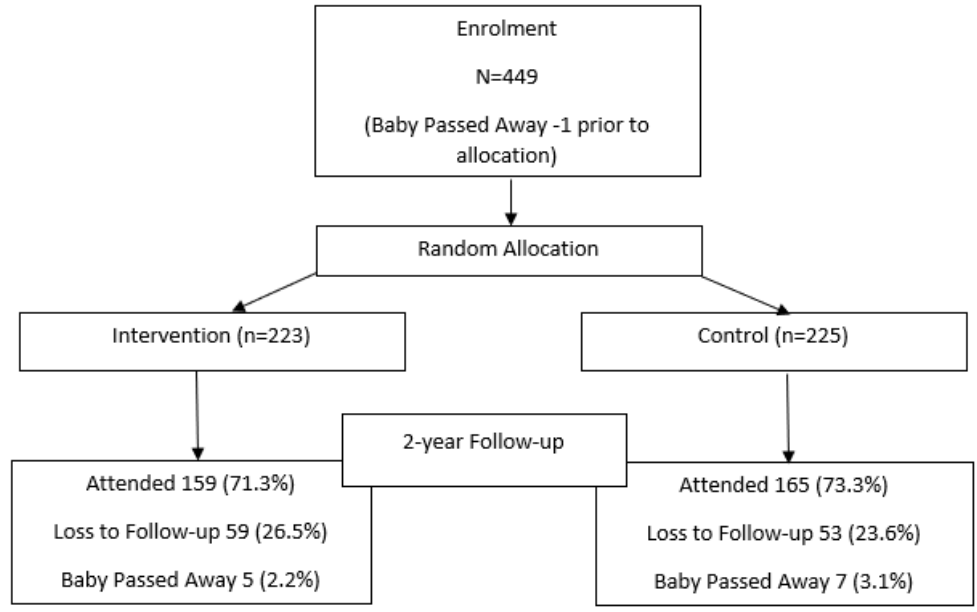
Figure 1. Baby Teeth Talk study participant recruitment, allocation and 2-year retention.